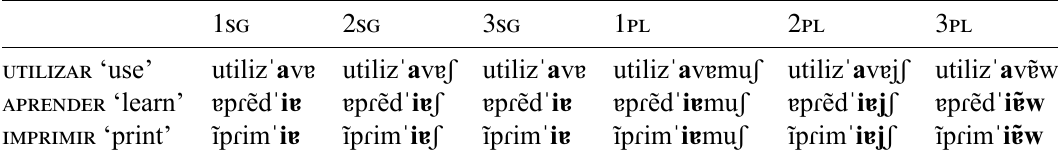
Table 14: Representative examples of the imperfect